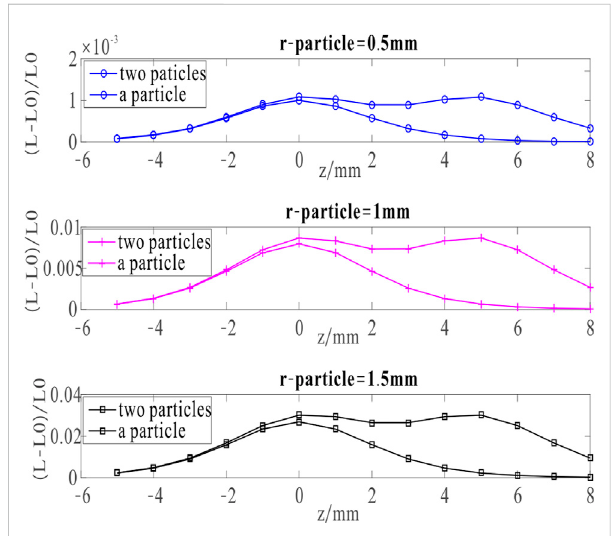
FIGURE 7 In fl uence ofdifferentparticlesizes on therelativevariation incoil inductance ( L-L 0 )/L 0 .